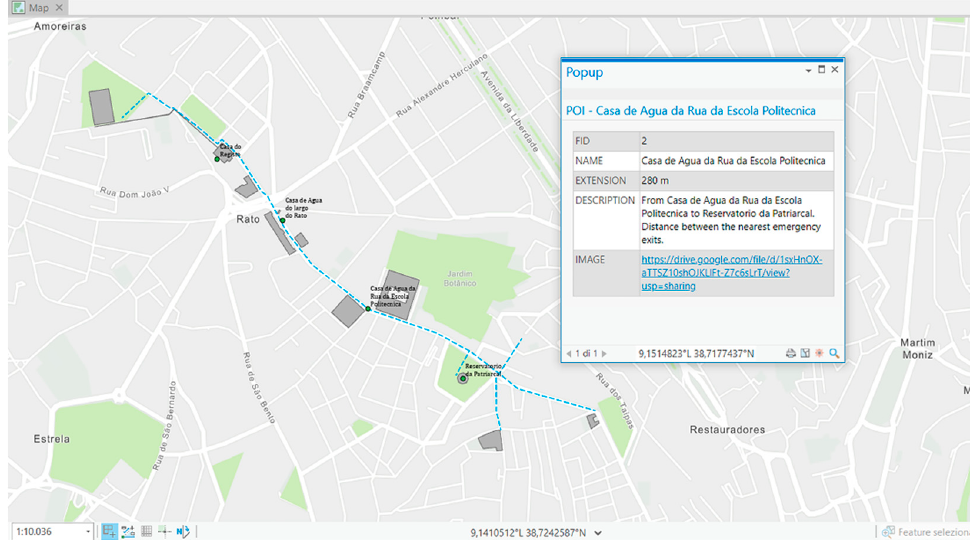
Figure 11. The 2D GIS map with POI referring to Galeria do Loreto.